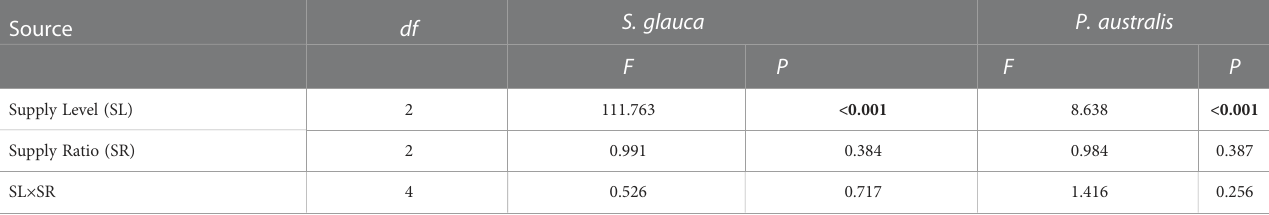
Signi fi cant P values are marked in bold (P < 0.05).